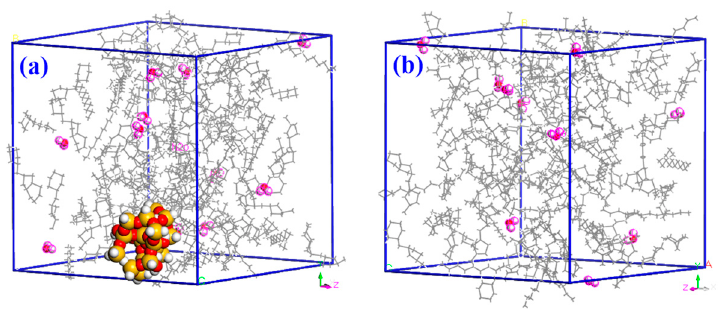
Figure 3. Diagrams of models ( a ) with and ( b ) without nano-SiO 2 .